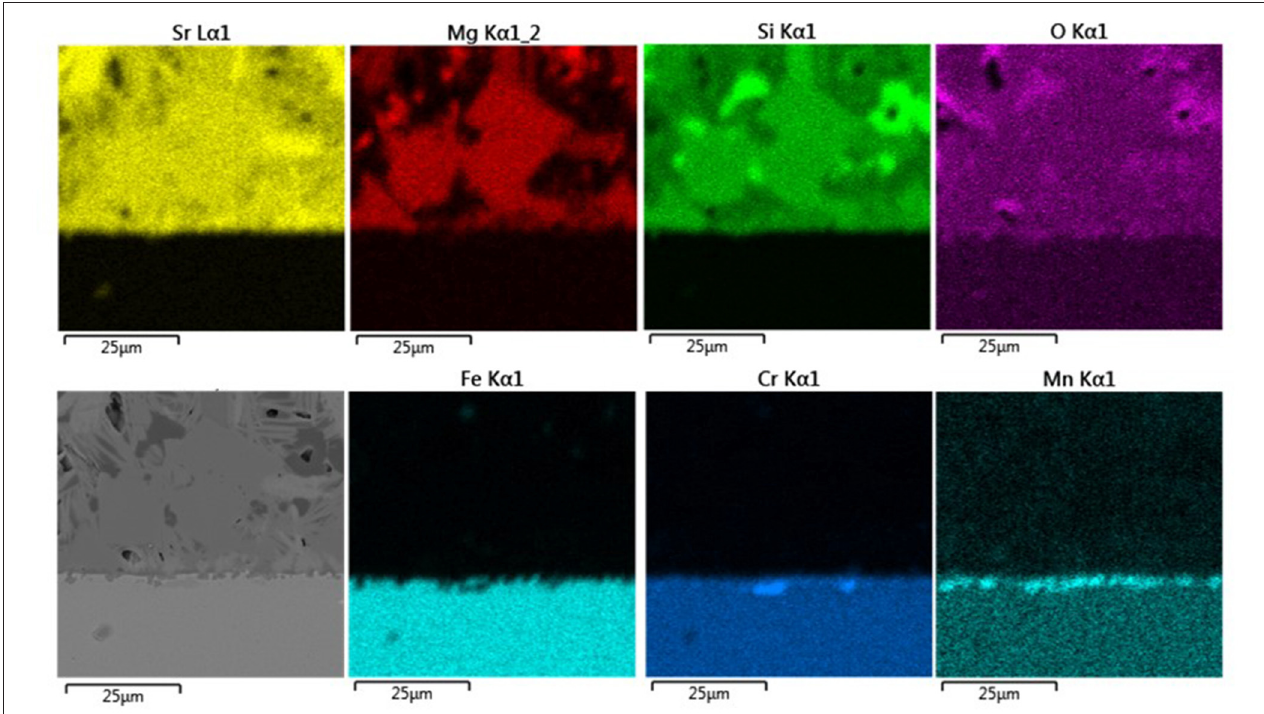
FIGURE 7 | EDX elemental mapping for the joint inferior steel-glass-ceramic 10B(Sr) treated at 800 ◦ C for 800 h.